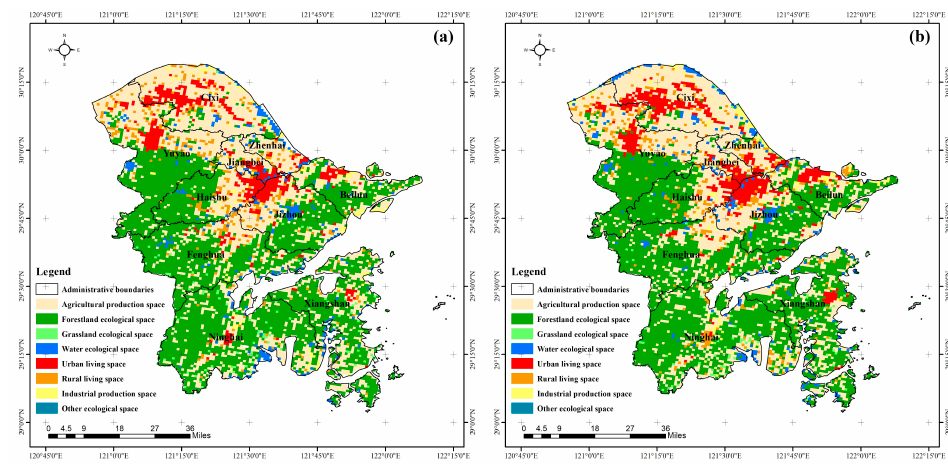
Figure 1. PLES in Ningbo for ( a ) 2010 and ( b )